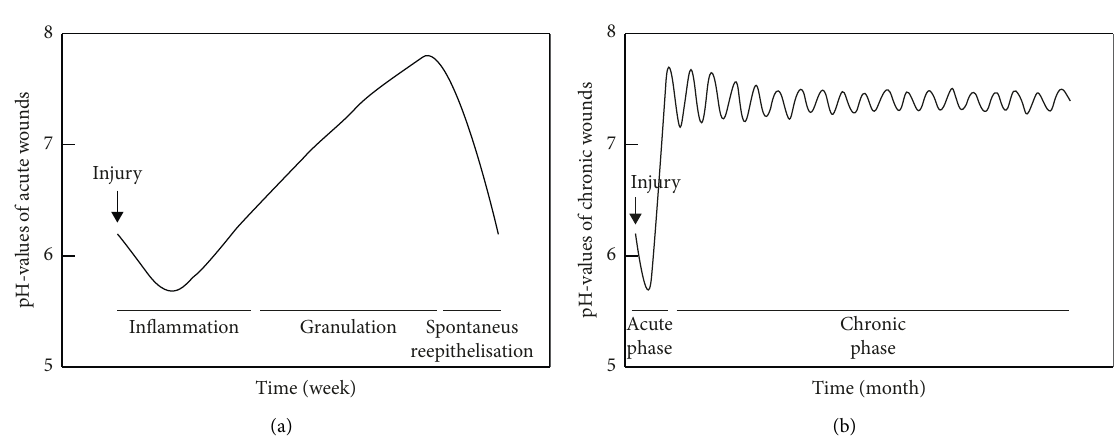
Figure 4: Time Vs pH of wounds (a) acute wound (b) chronic wound [27]. (The pH value on the wound site is found to vary according to the wound healing stages as shown in (a) and (b). Once an injury creates an acute wound, the underlying tissue was exposed and the pH is regulated at 7.4, which may allow bacterial growth and the risk of promoting infection. As a countering, a temporary acidosis will occur during the inflammation stage (a), and the pH of chronic wounds is more alkaline